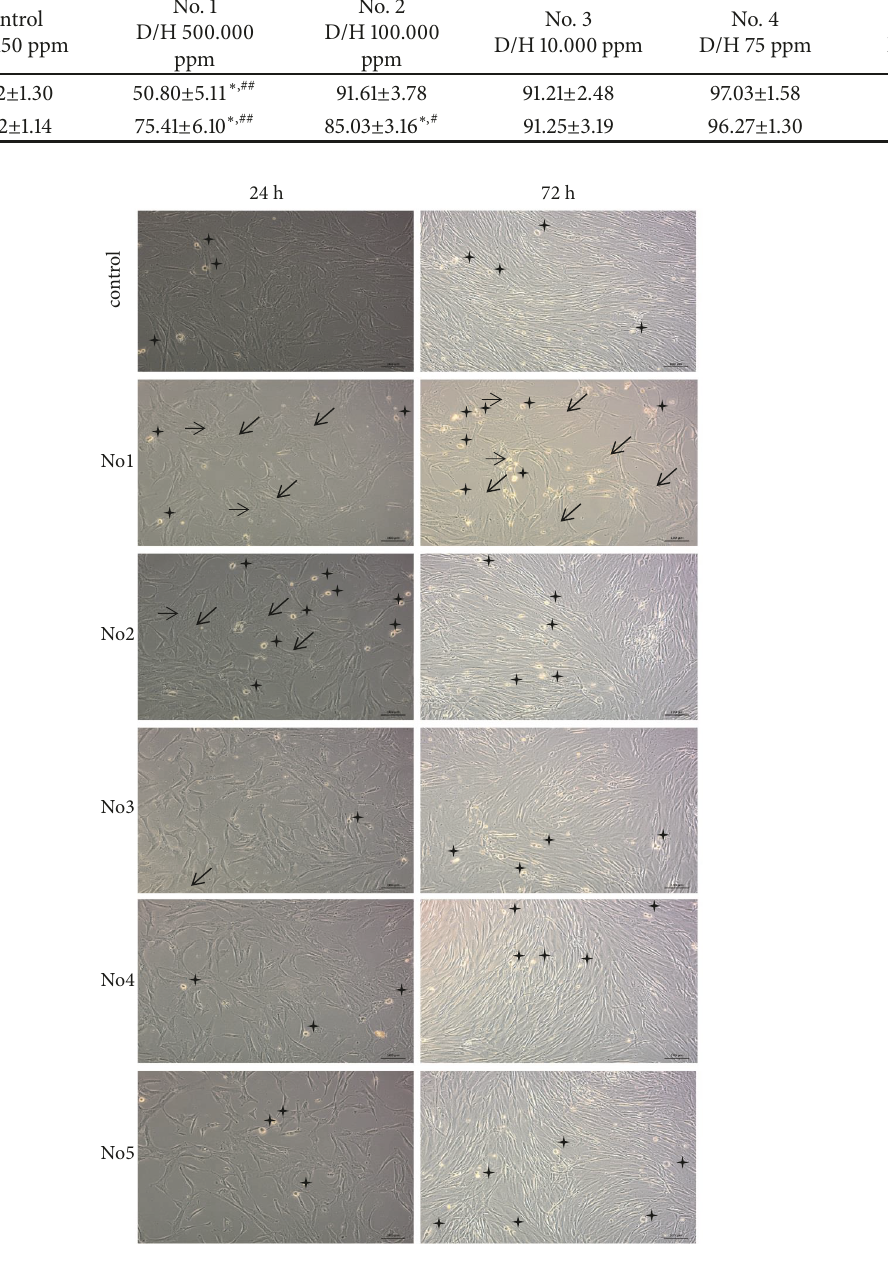
Figure 2: The morphology of ADSCs cultured in control medium and media with different deuterium content for 24h (left panel) and 72h (right panel). Deuterium concentration: control: D/H 150 ppm; No. 1: D/H 500.000 ppm; No. 2: D/H 100.000 ppm; No. 3: D/H 10.000 ppm; No. 4: D/H 75 ppm; No. 5: D/H 15 ppm. Phase-contrast microscopy. ↙ : stress fibers, a : cell granularity, and ∗ : mitotic